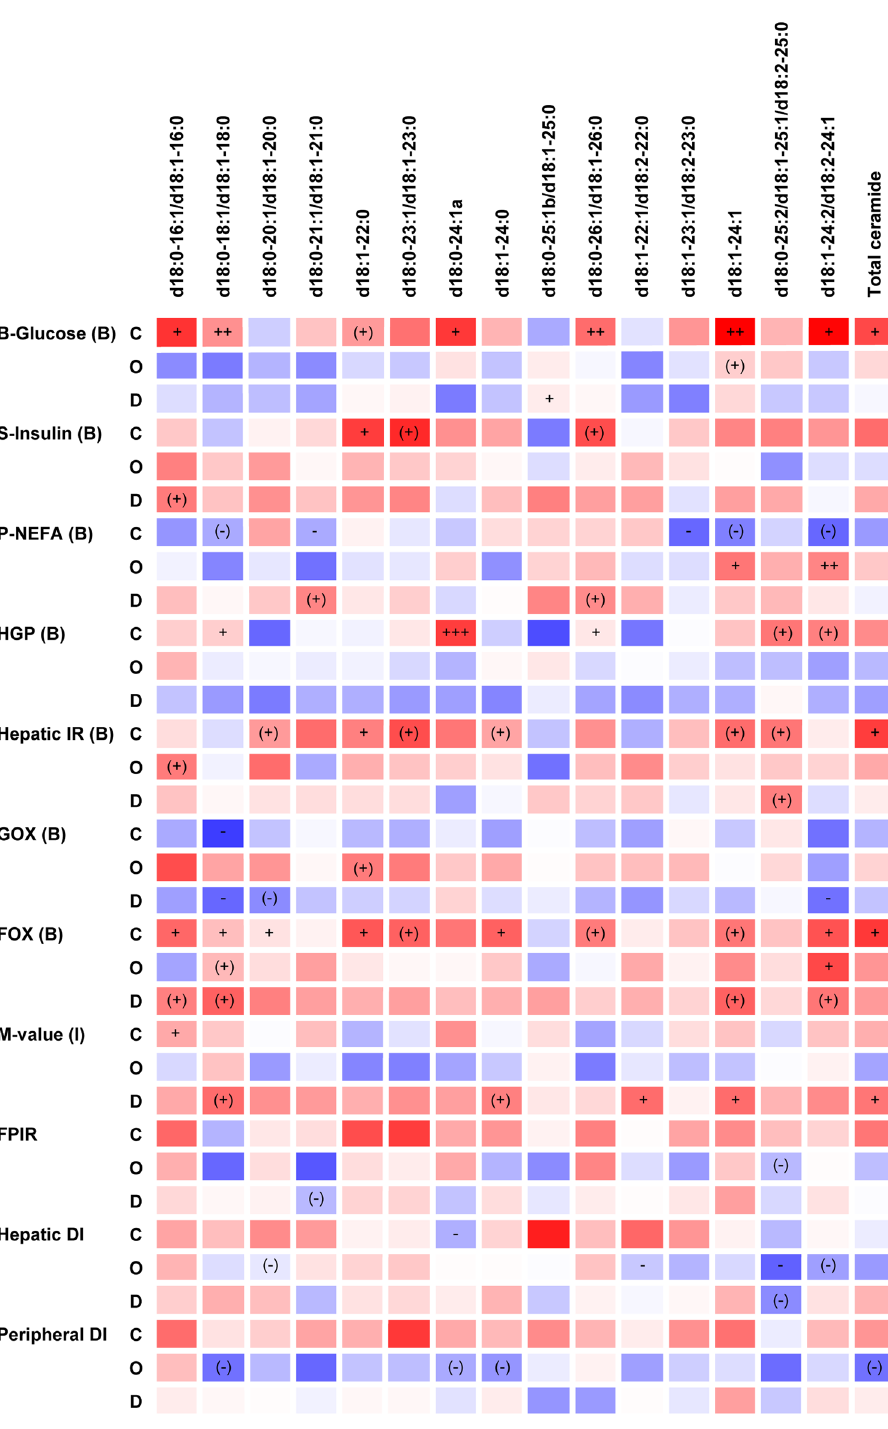
Figure 1. Heat-map of associations between plasma ceramide levels and physiological measures following the control (C) and high-fat, high-calorie (O) diets and between response values (D). Data are presented as r-values (red or blue colour variations for positive or negative values, respectively) and P-values ( + / − : P ≤ 0.05, ++ / − − : P ≤ 0.01, +++ / −−− : P ≤ 0.001, ( + )/( − ): P ≤ 0.1 for positive or negative associations, respectively). r-values are in the range − 0.4 to 0.4. P-values are presented unadjusted for multiple comparisons, and P-values ≤ 0.05 are considered statistically significant. Regression analyses were performed on the pooled data set of LBW and NBW men and were adjusted for age, BMI, and birth weight group. B or I indicated in parentheses after clamp measures specify basal or insulin-stimulated state, respectively. Other abbreviations: See Table